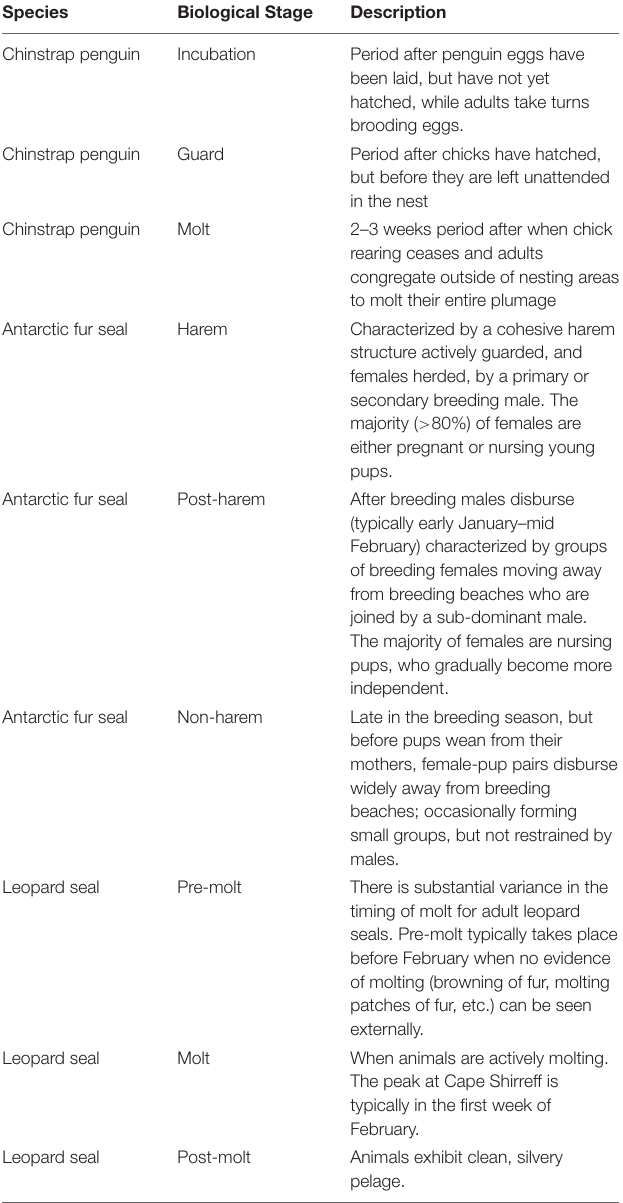
TABLE 1 | Names and descriptions of the three breeding chronology or biology stages targeted during ground and aerial surveys for all three study species. Species